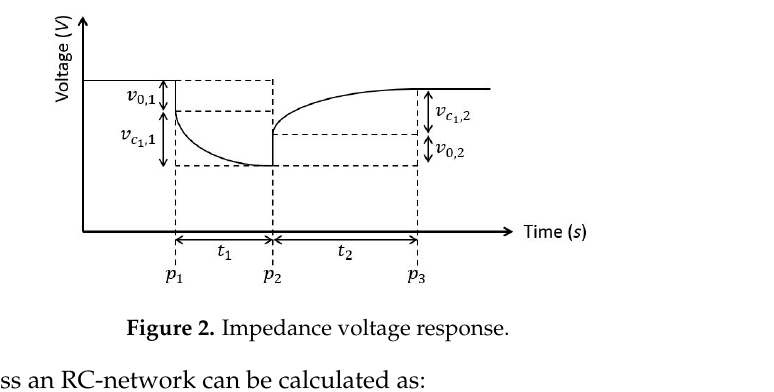
Figure 2. Impedance voltage response.